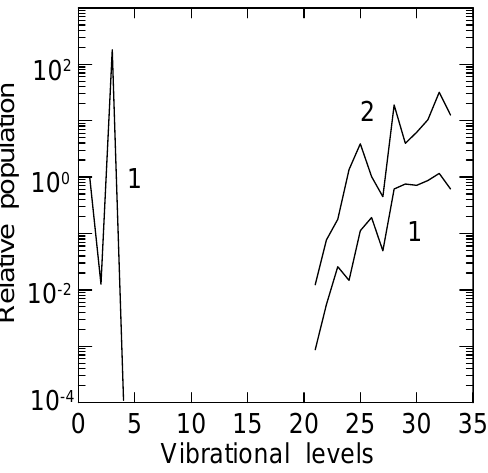
Fig. 14. The same as in Fig. 11, but for the a 1 1 g state: 1 and 2 – without and with the contribution of processes (4b).